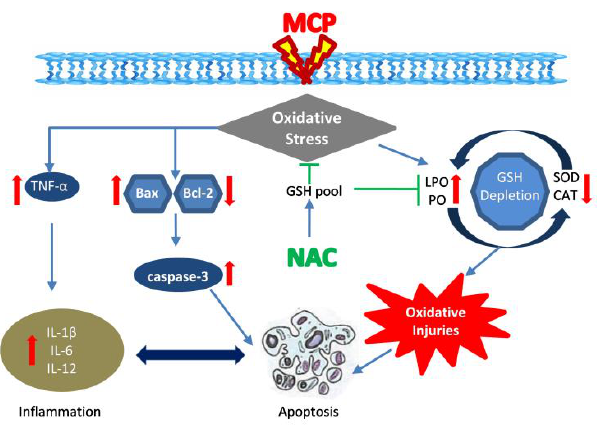
Figure 5. Hypothetical representation of protective potential of NAC against MCP-induced hepa- totoxicity in rats.